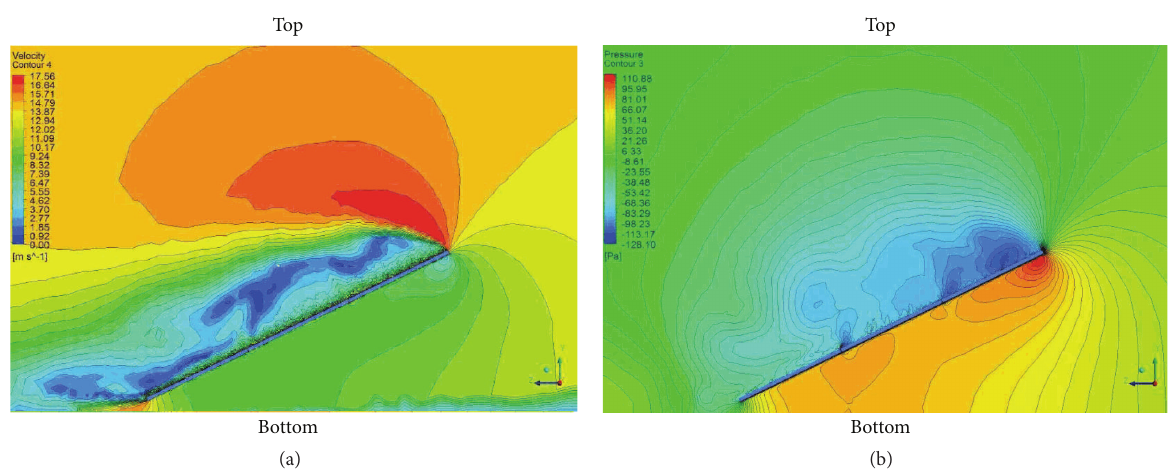
Figure 14: (a) Velocity magnitude (m/s) and (b) static pressure (N/m 2 ) contours at panels with holes, Section 1 , Figure 12, wind from right to